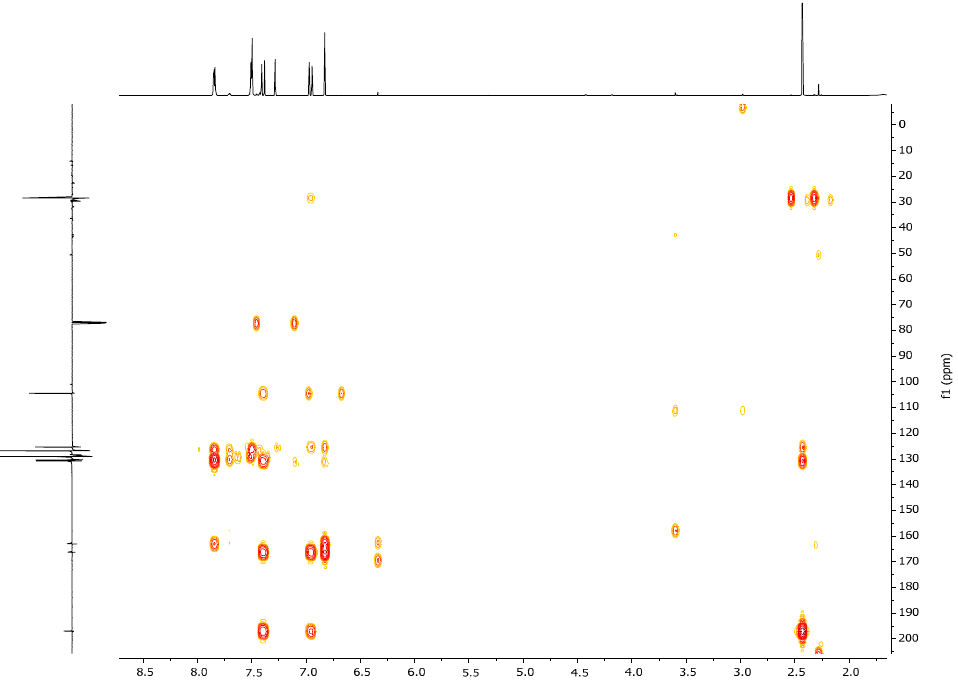
Figure 2. Data of 1 H- 13 C heteronuclear multiple-bond correlation spectroscopy for compound (E)- 4c (CDCl 3 ).